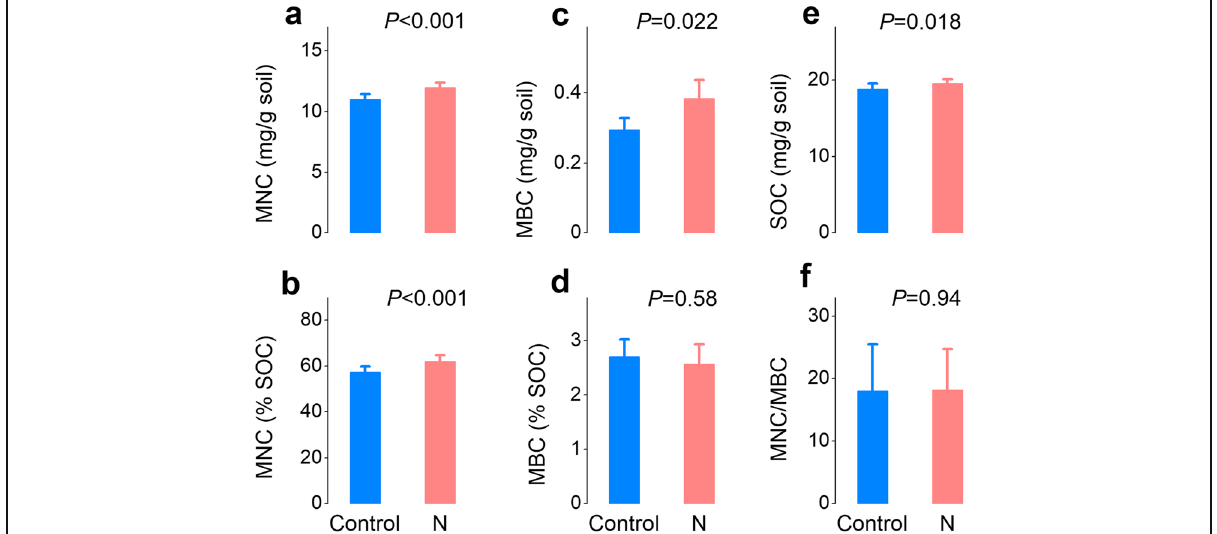
Fig. 1 Average concentrations of a , b microbial necromass C (MNC) and c , d biomass C (MBC) at control and N addition plots. e Average concentrations of soil organic C (SOC) at control and N addition plots. f Average ratios of microbial necromass C to microbial biomass C at control and N addition plots. The above panels show the values presented on the basis of soil dry mass (mg/g soil), and the below panels show the values presented as percentages of soil organic C (% SOC). Error bars represent the standard errors. The MBC values were analyzed by the chloroform fumigation extraction method. The data in panel f were collected only from cropland sites, at which the MBC concentrations were